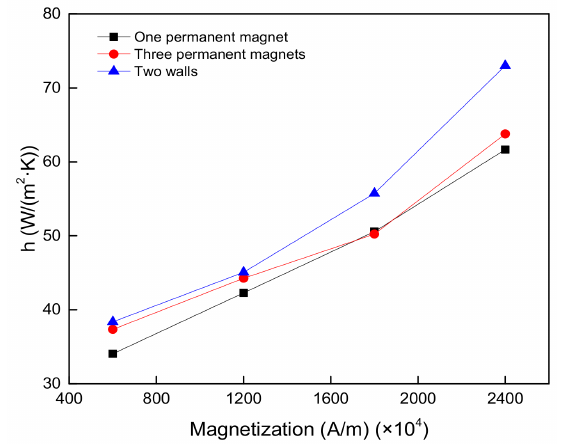
Figure 12. Convective heat transfer coefficient at three cases.